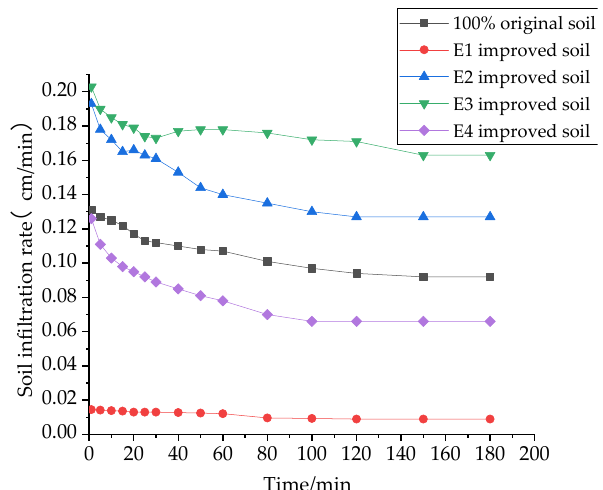
Figure 9. Effect of the interweaving of amendments and structural ameliorants on the soil infiltration rate.